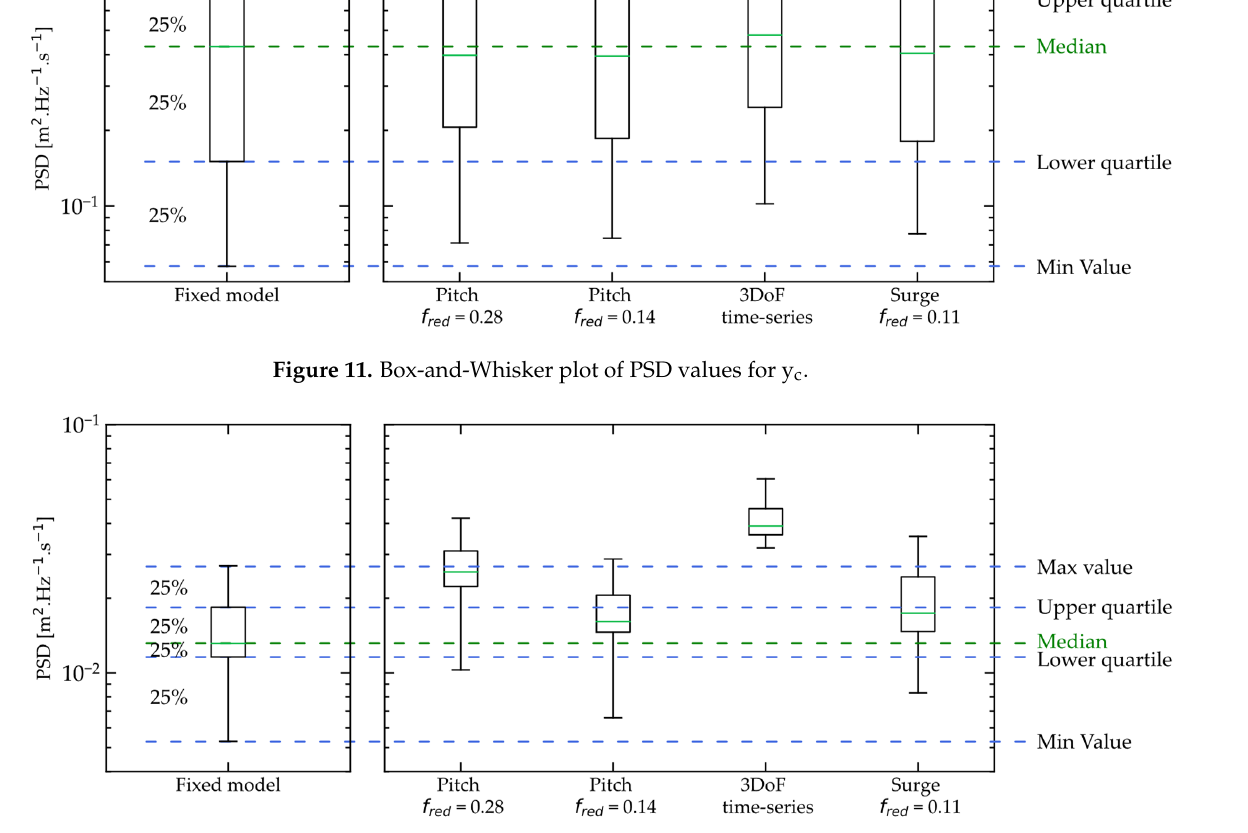
Figure 12. Box-and-Whisker plot of PSD values for z c .